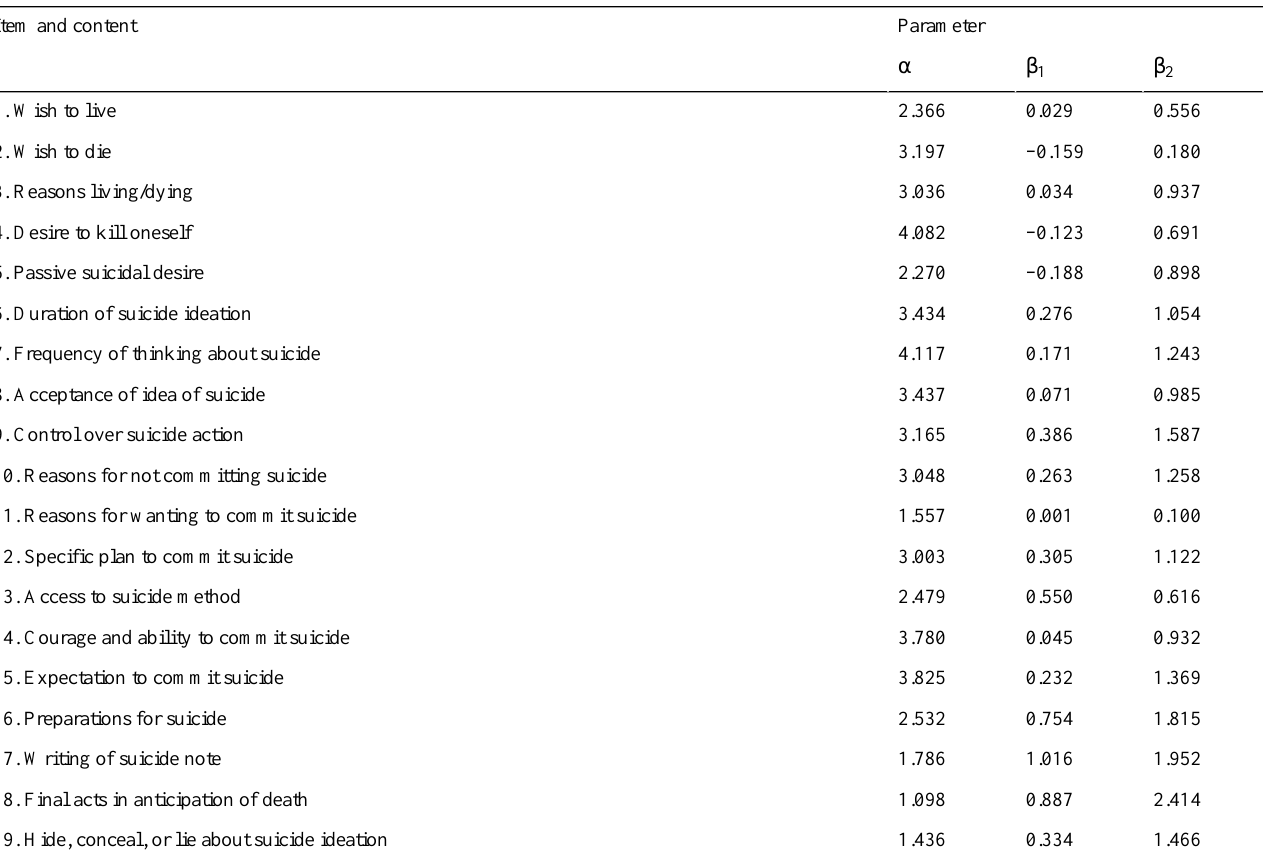
Table 2. Graded response model parameters for the Dutch version of the Beck Scale for Suicide Ideation (BSS-NL). ParameterItem and